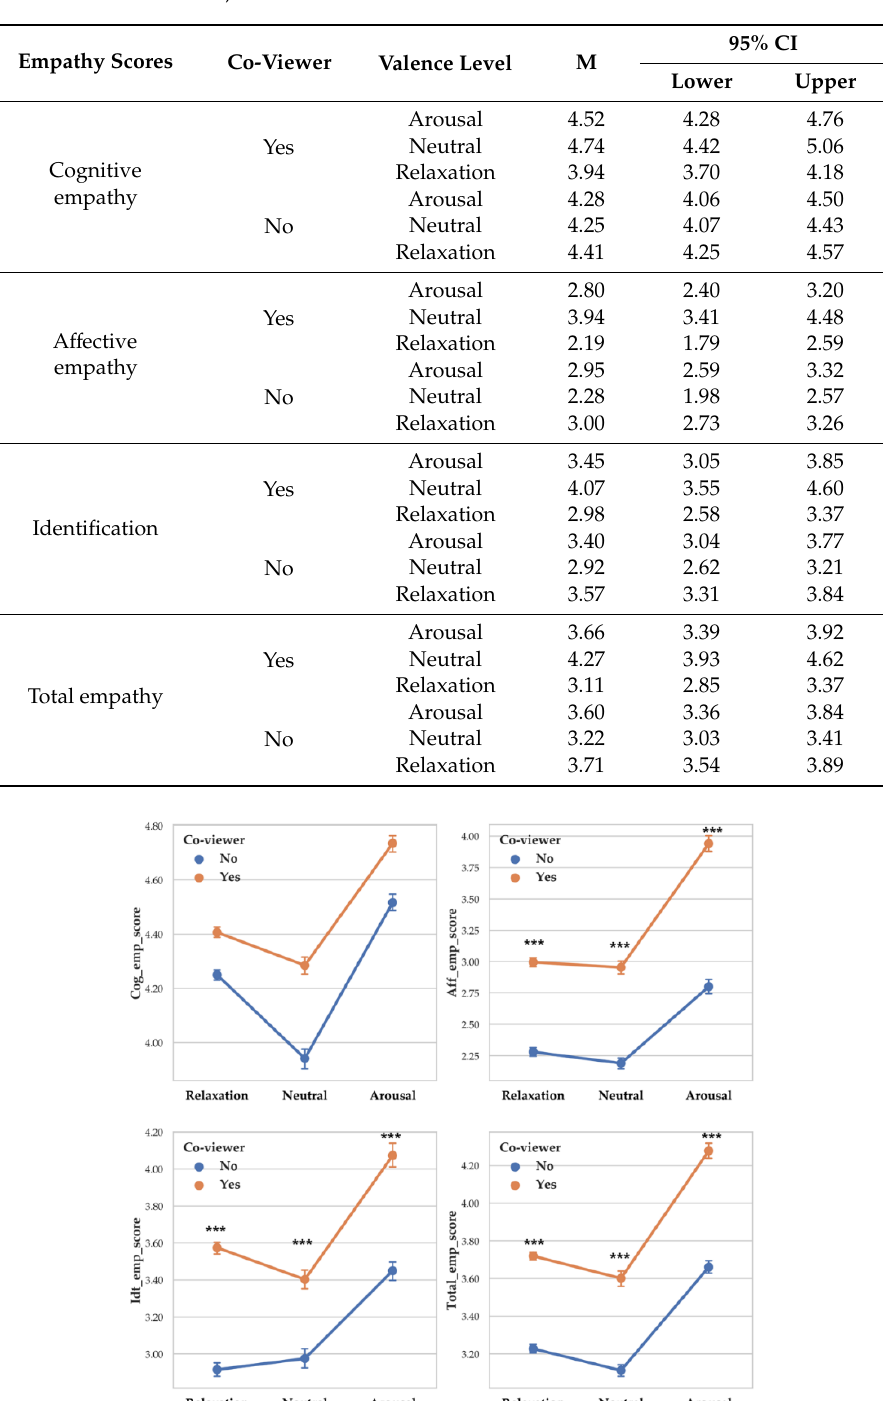
Table 13. Descriptive statistics: Self-reporting empathy scores depending on existence of co-viewer and arousal level. M = Mean, SD = Standard deviation.